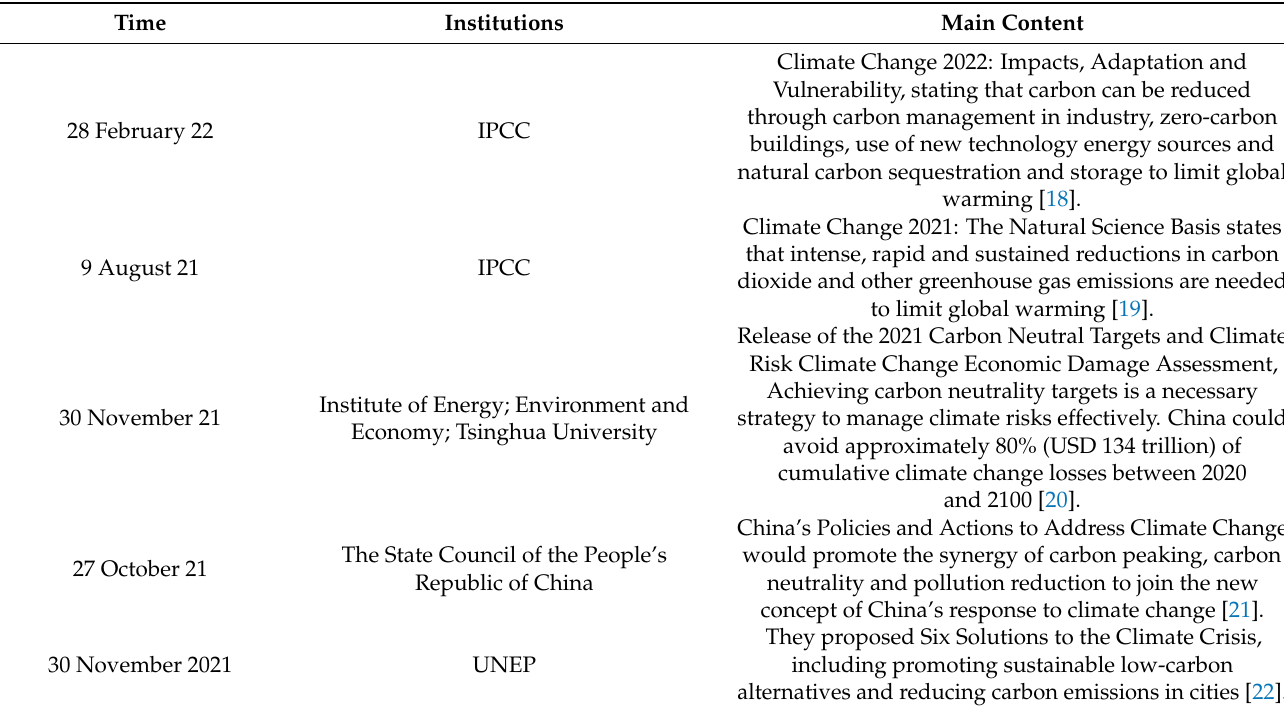
Table 1. RCHSCC-related